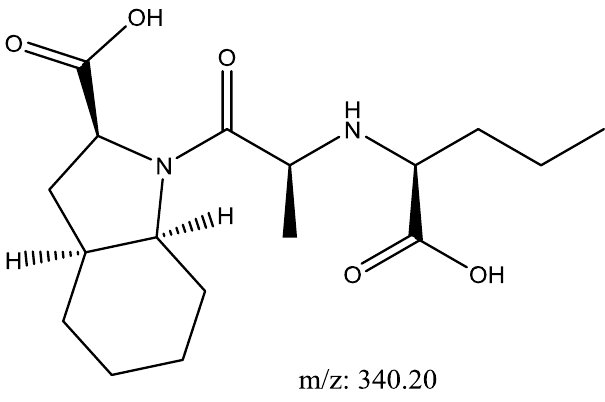
Figure 4. Suggested basic degradation product for Perindopril.